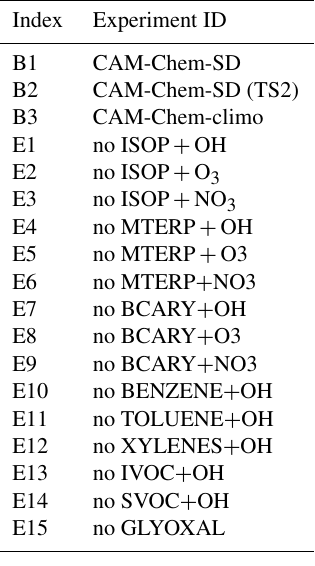
Table 2. CESM experiments used in this study. SVOC signifies the semi-volatile organic precursor of VBS